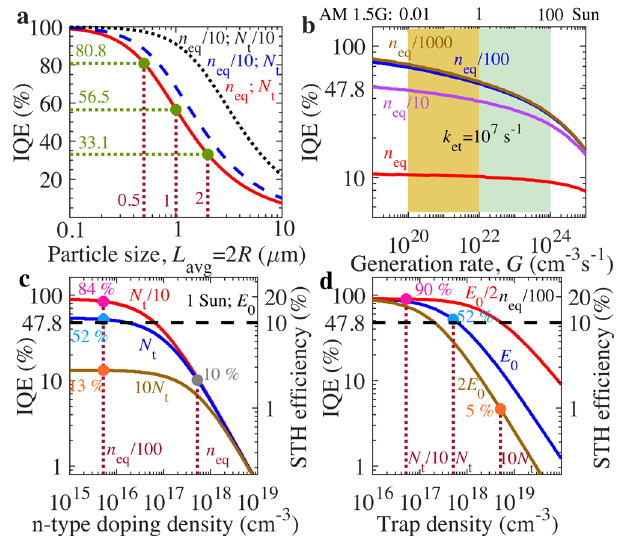
Fig. 5 Optimization design strategies to realize high ef fi ciency for Y 2 Ti 2 O 5 S 2 photocatalyst. a Impact of particle size, n-type donor density n eq and trap density N t on internal quantum ef fi ciency (IQE). b In fl uence of n eq at various charge carrier generation rate G for charge extraction rate k et = 10 7 s − 1 . c , d Effect of n eq , N t , and characteristic energy E 0 on the IQE and STH ef fi ciency of Y 2 Ti 2 O 5 S 2 photocatalyst. Here, n eq ; N t , and E 0 correspond to the estimated values (in Supplementary Table 1) from the TA decay kinetics. The IQE and STH ef fi ciency is calculated from Eq. (3) and Supplementary Note 5. Source data are provided as a Source Data fi